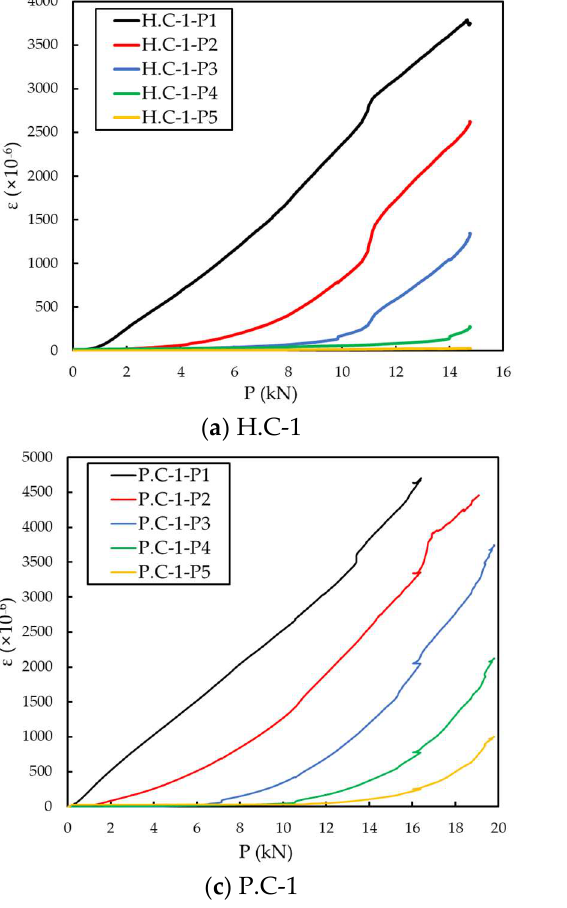
Figure 9. Partial tensile strain for CFRP/GFRP grid points.